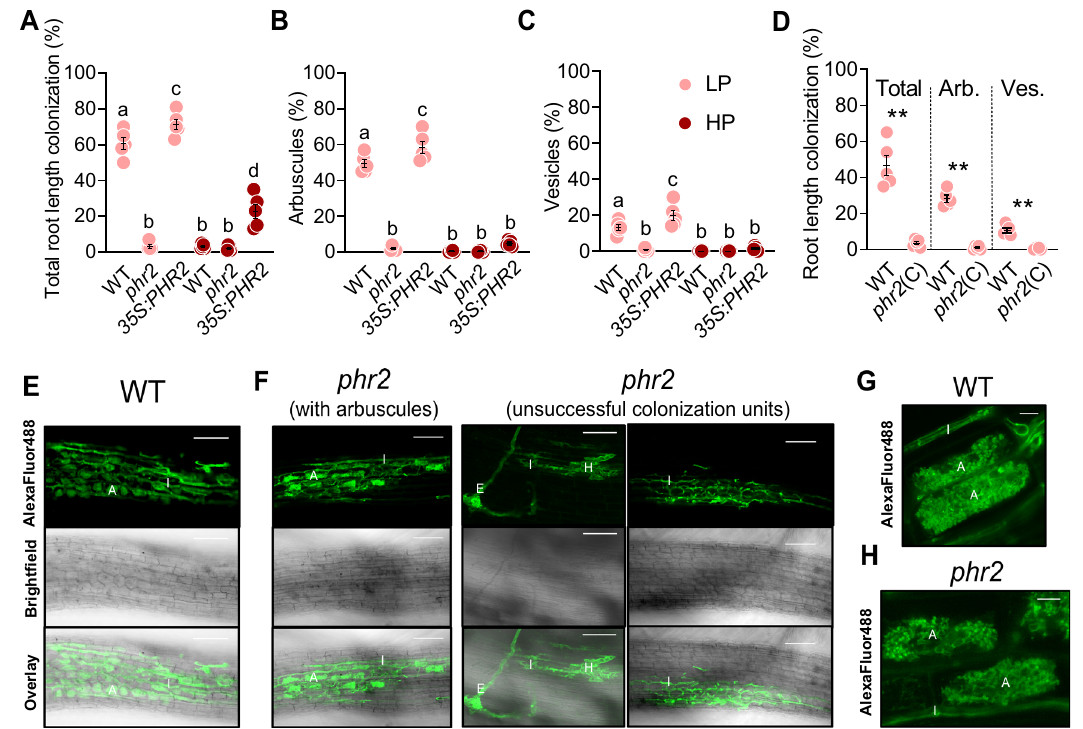
Fig. 1 Effect of PHR2 mutation and overexpression on root colonization by AM fungi. Percent root length colonization (RLC) total ( A ), arbuscules ( B ), and vesicles ( C ) of the indicated genotypes inoculated with R. irregularis (AMF) for 7 weeks at low phosphate (25 µ M P i , LP) or high phosphate (500 µ M P i , HP). D Percent RLC of the indicated genotypes inoculated with AMF for 7 weeks at LP. Arb.: Arbuscules; Ves.: Vesicles. Confocal images of AMF in roots of wild type ( E ) and phr2 ( F ). Arbuscule phenotype in wild type ( G ) and phr2 ( H ) roots. E, extraradical hypha; H, hyphopodium; I, intraradical hypha; A, arbuscule. Scale-bars: E, F: 100 μ m and G, H: 10 μ m. Statistics: Individual data points and mean ± SE are shown. A – C N = 5 independent plants;